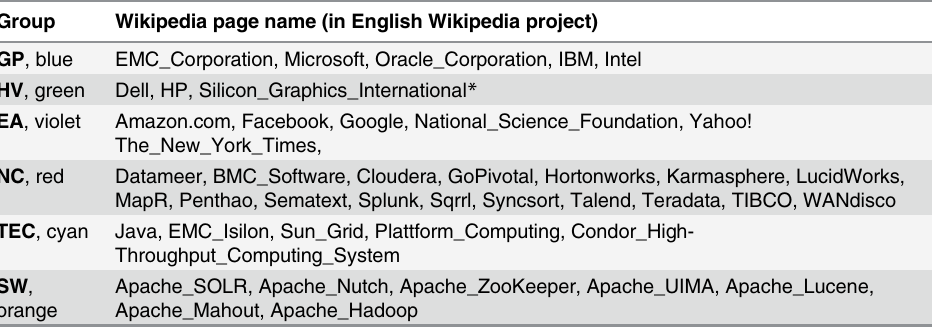
Table 1. Selection of English Wikipedia pages (CNs) regarding topics with a direct relation to the emerging Hadoop (Big Data) market. Apache Hadoop is the central software project, beside Apache SOLR, and Apache Lucene (SW, software). Companies which offer Hadoop distributions and Hadoop based solutions are the central companies in the scope of the study (HV, hardware vendors). Other companies started very early with Hadoop related projects as early adopters (EA). Global players (GP) are affected by this emerging market, its opportunities and the new competitors (NC). Some new but highly relevant compa- nies like Talend or LucidWorks have been selected because of their obvious commitment to the open source ideas. Widely adopted technologies with a relation to the selected research topic are represented by the group TEC.